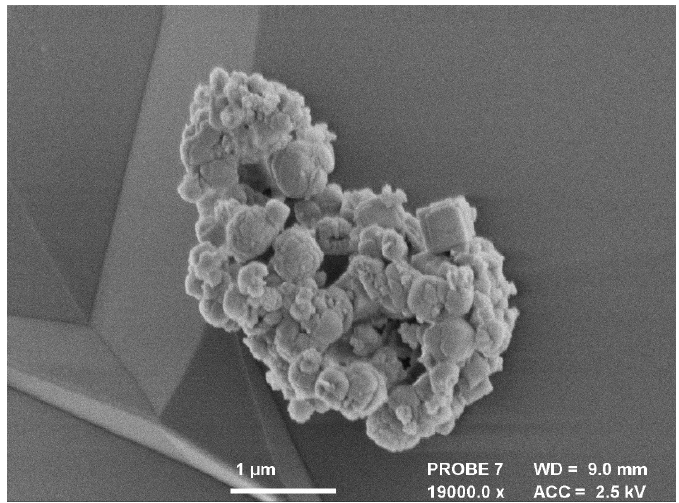
Figure 15. FESEM